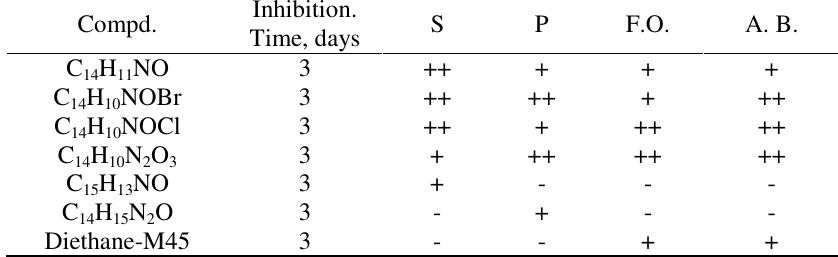
Table 3. Results of inhibition of synthesized ketoazomethines